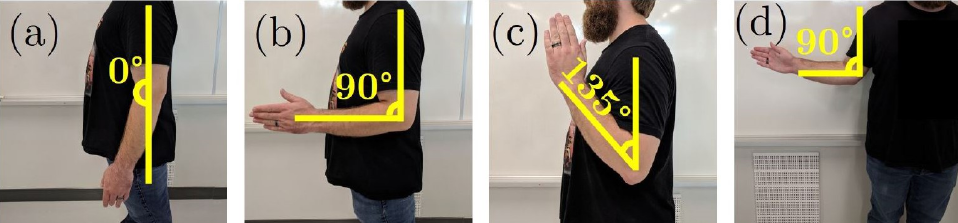
Figure 3. Arm positions used during data acquisition. ( a ) Forearm at full extension (0 ◦ ). ( b ) Forearm flexed at 90 ◦ . ( c ) Forearm flexed at 135 ◦ . ( d ) Forearm at 90 ◦ flexion while externally rotating the shoulder through a comfortable range of